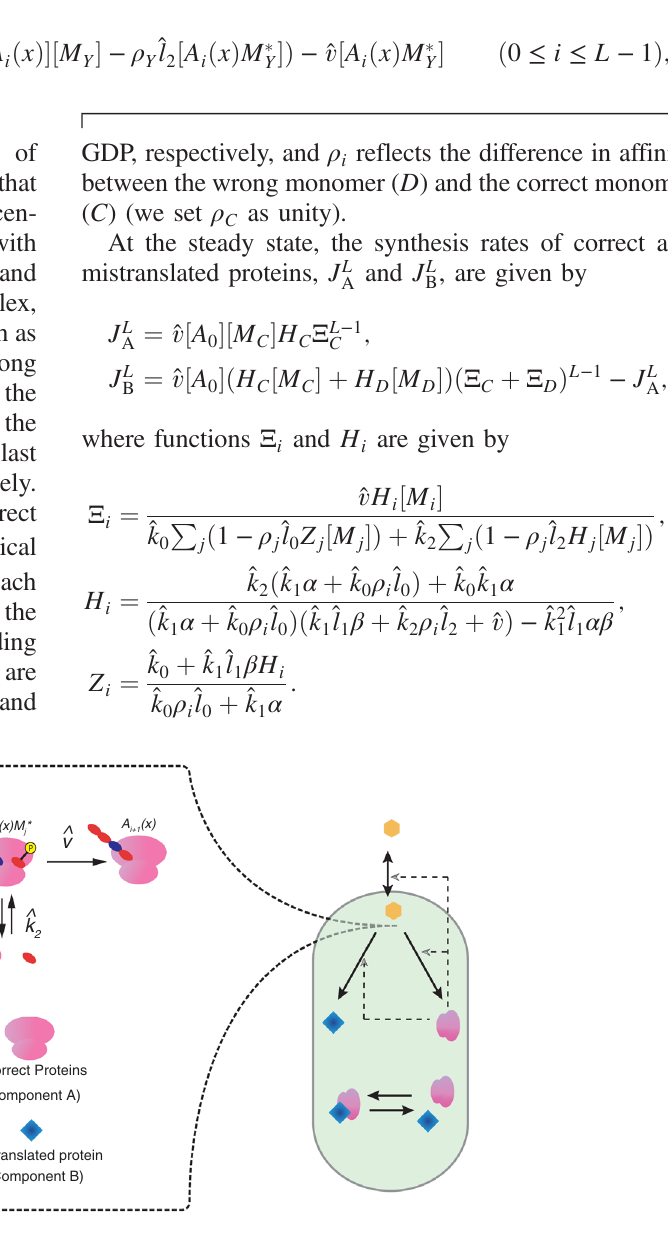
FIG. 7. Schematic representation of a polymer elongation system with kinetic proofreading. The reactions, other than the synthesis part [ F A ð S Þ A and F B ð S Þ A ], are identical to those of the original model